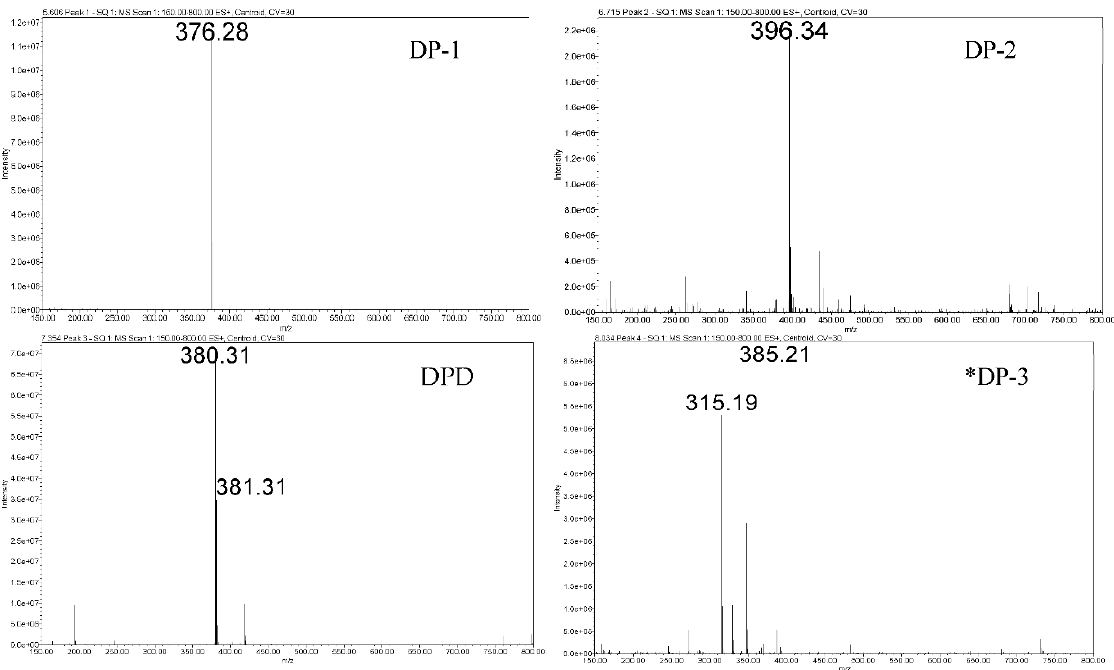
Figure 4. LC − SqD MS characterization of DPD and its DPs. (*The structure of DP - 3 could not be justified based on the available data).